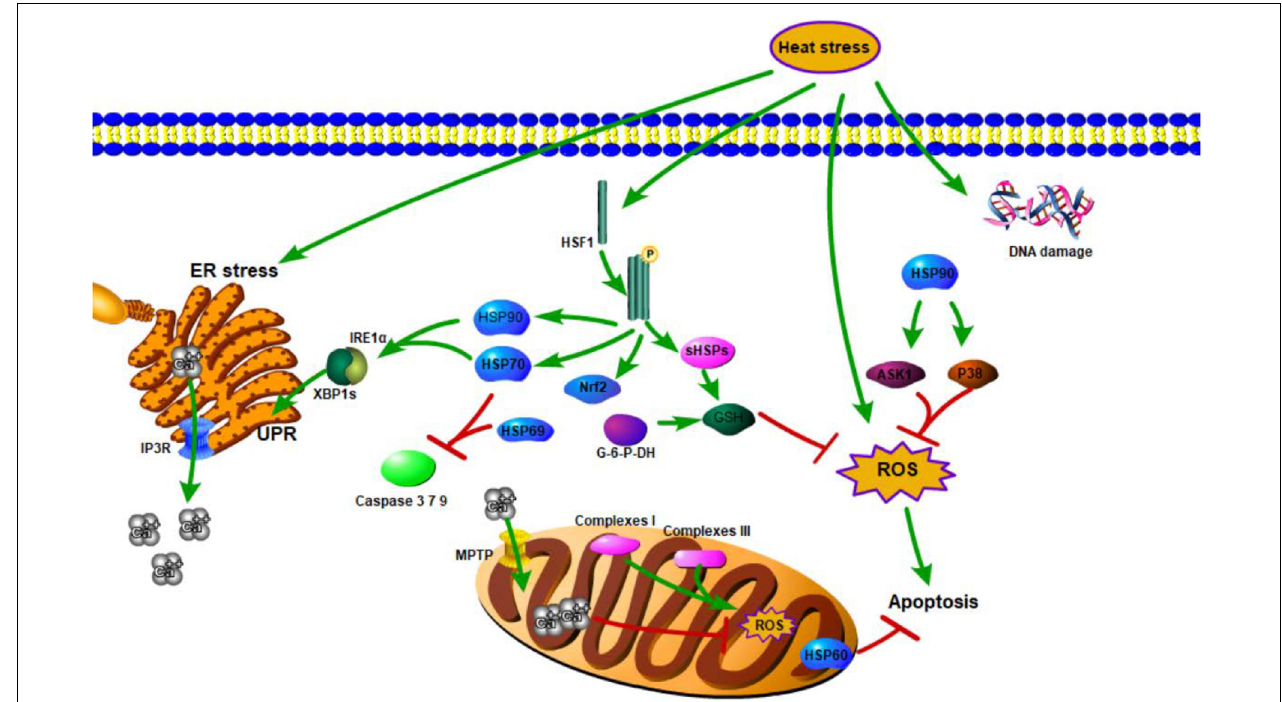
FIGURE 1 | Genetic mechanisms of animal responses to heat.